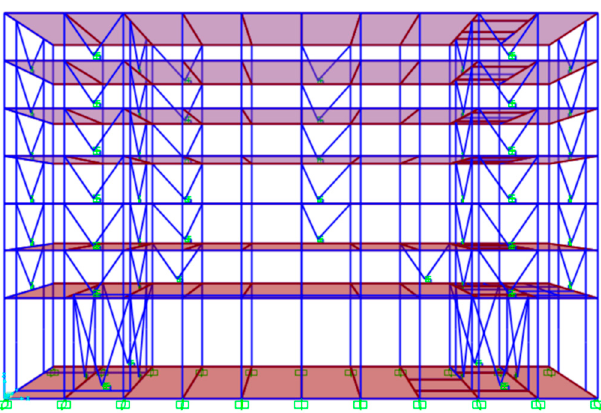
Figure 4. Finite element model of the building as developed in SAP2000 environment.